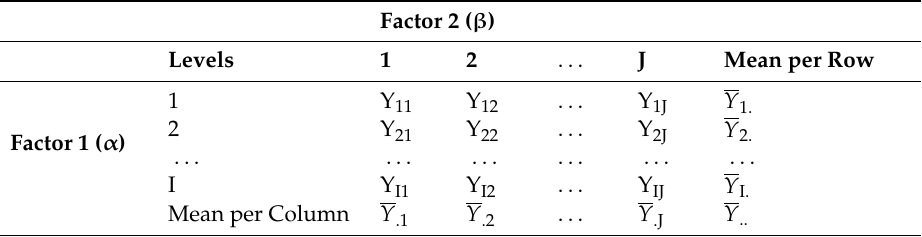
Table 4. Calculation of residuals for BPSK.